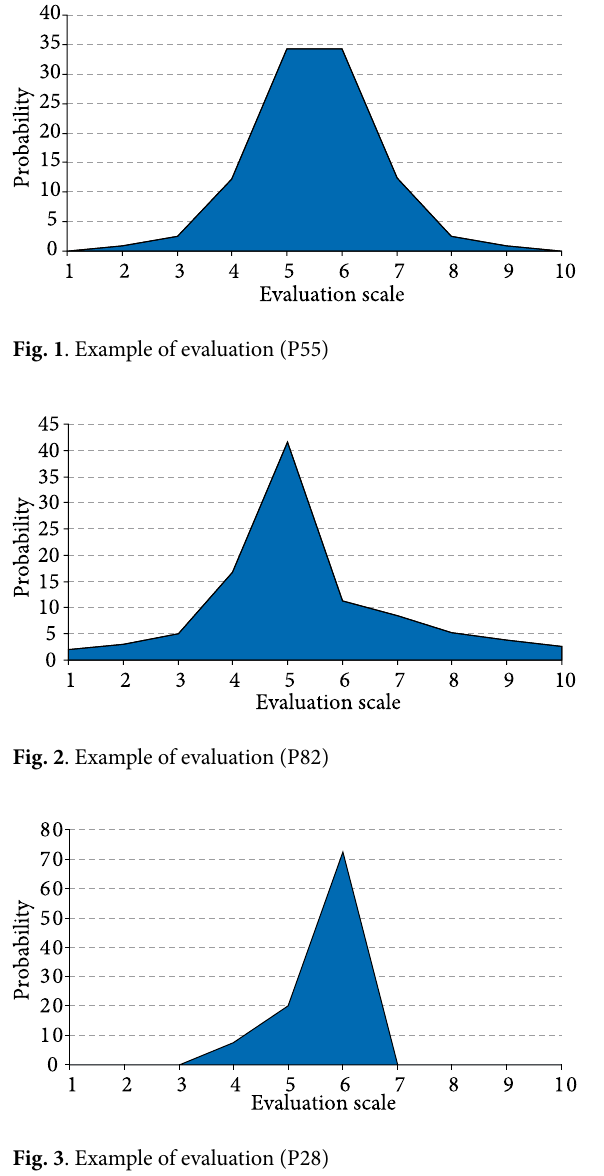
Fig. 3 . Example of evaluation (P28)